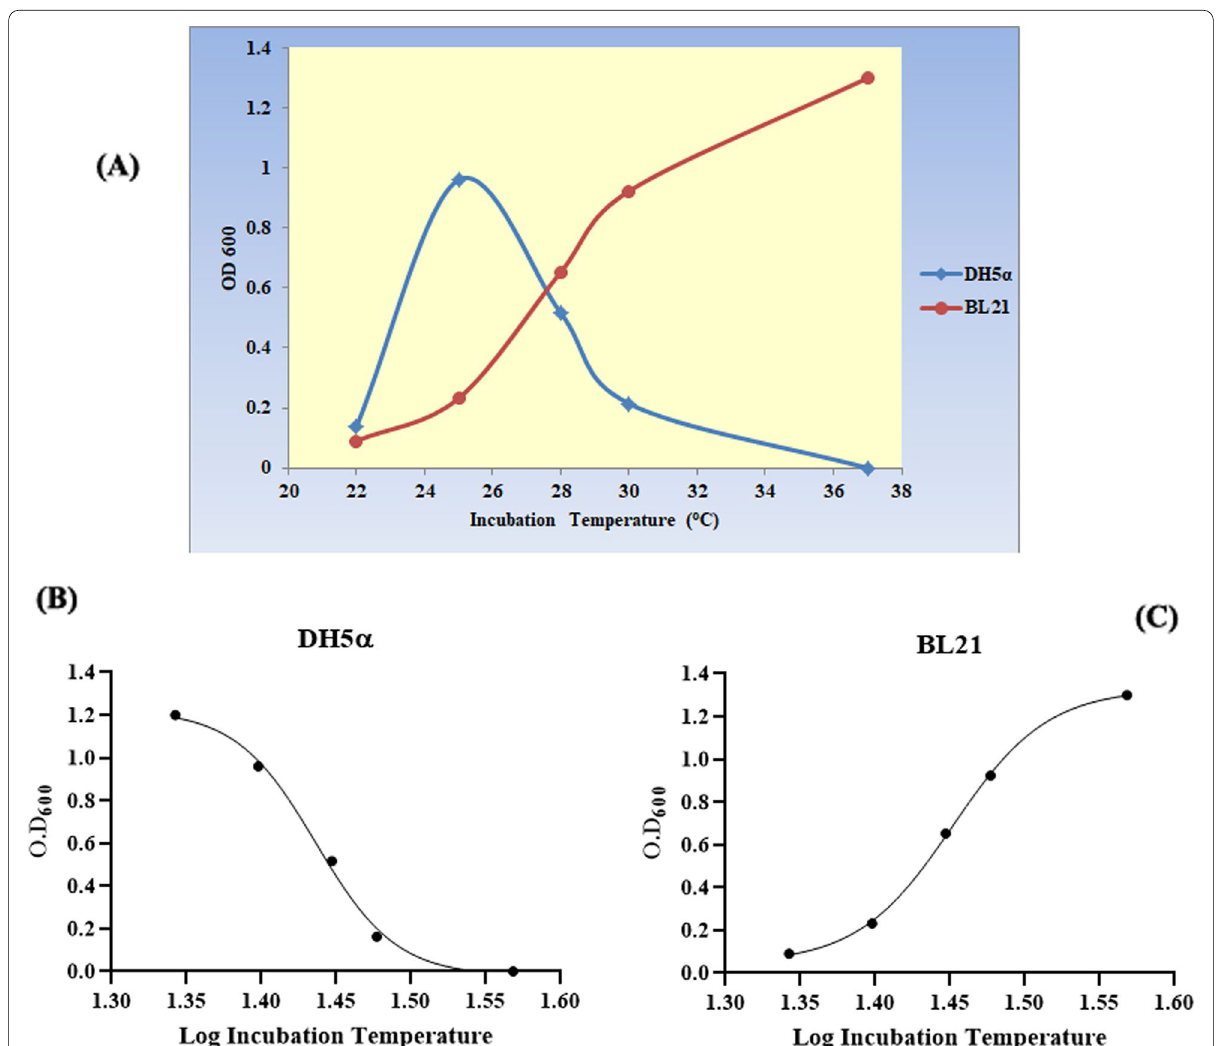
Fig. 3 The growth kinetics of recombinant E. coli DH5α and BL21 (DE3) ( A ). Cultures of E. coli DH5α showed higher growth density and rate as incubation temperature declined, achieving the highest growth rate at 25 °C. Non‑linear regression analysis is demonstrated to show the inverse correlation ( r 0.9383, P 0.0091) between growth rate and temperature. Unlike DH5α, cultures of BL21 (DE3) showed a positive correlation with = − = growth temperature ( r 0.9779, P 0.002) ( B ), where they grew faster in elevated temperatures reaching the maximum at 37 °C ( C = =